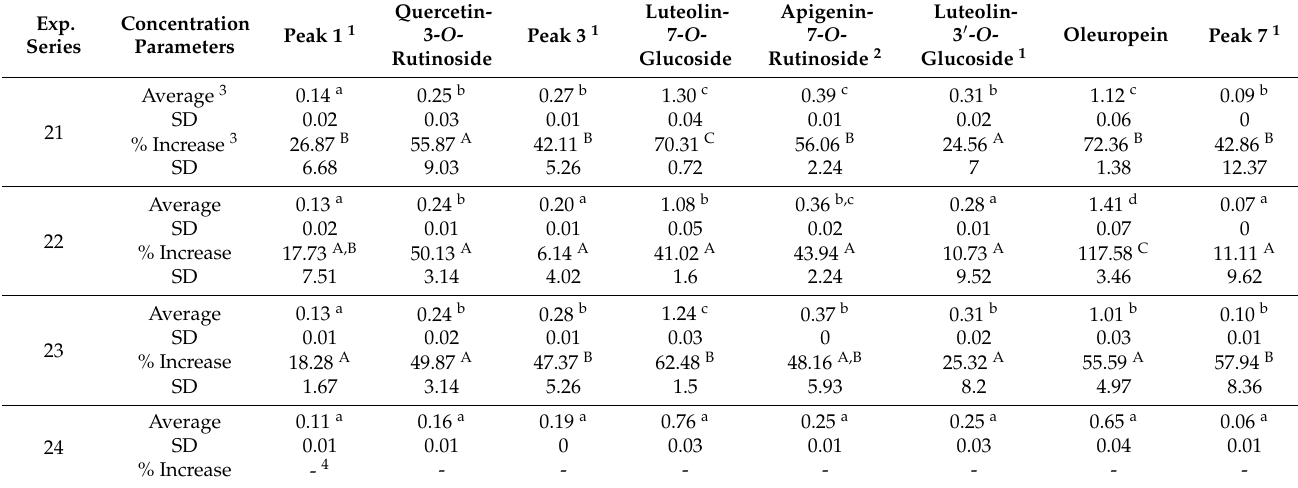
Table 3. Major compounds concentration (mg g − 1 dw) of OLL extracts prepared with 25% aqueous ethanol for extraction duration of 15